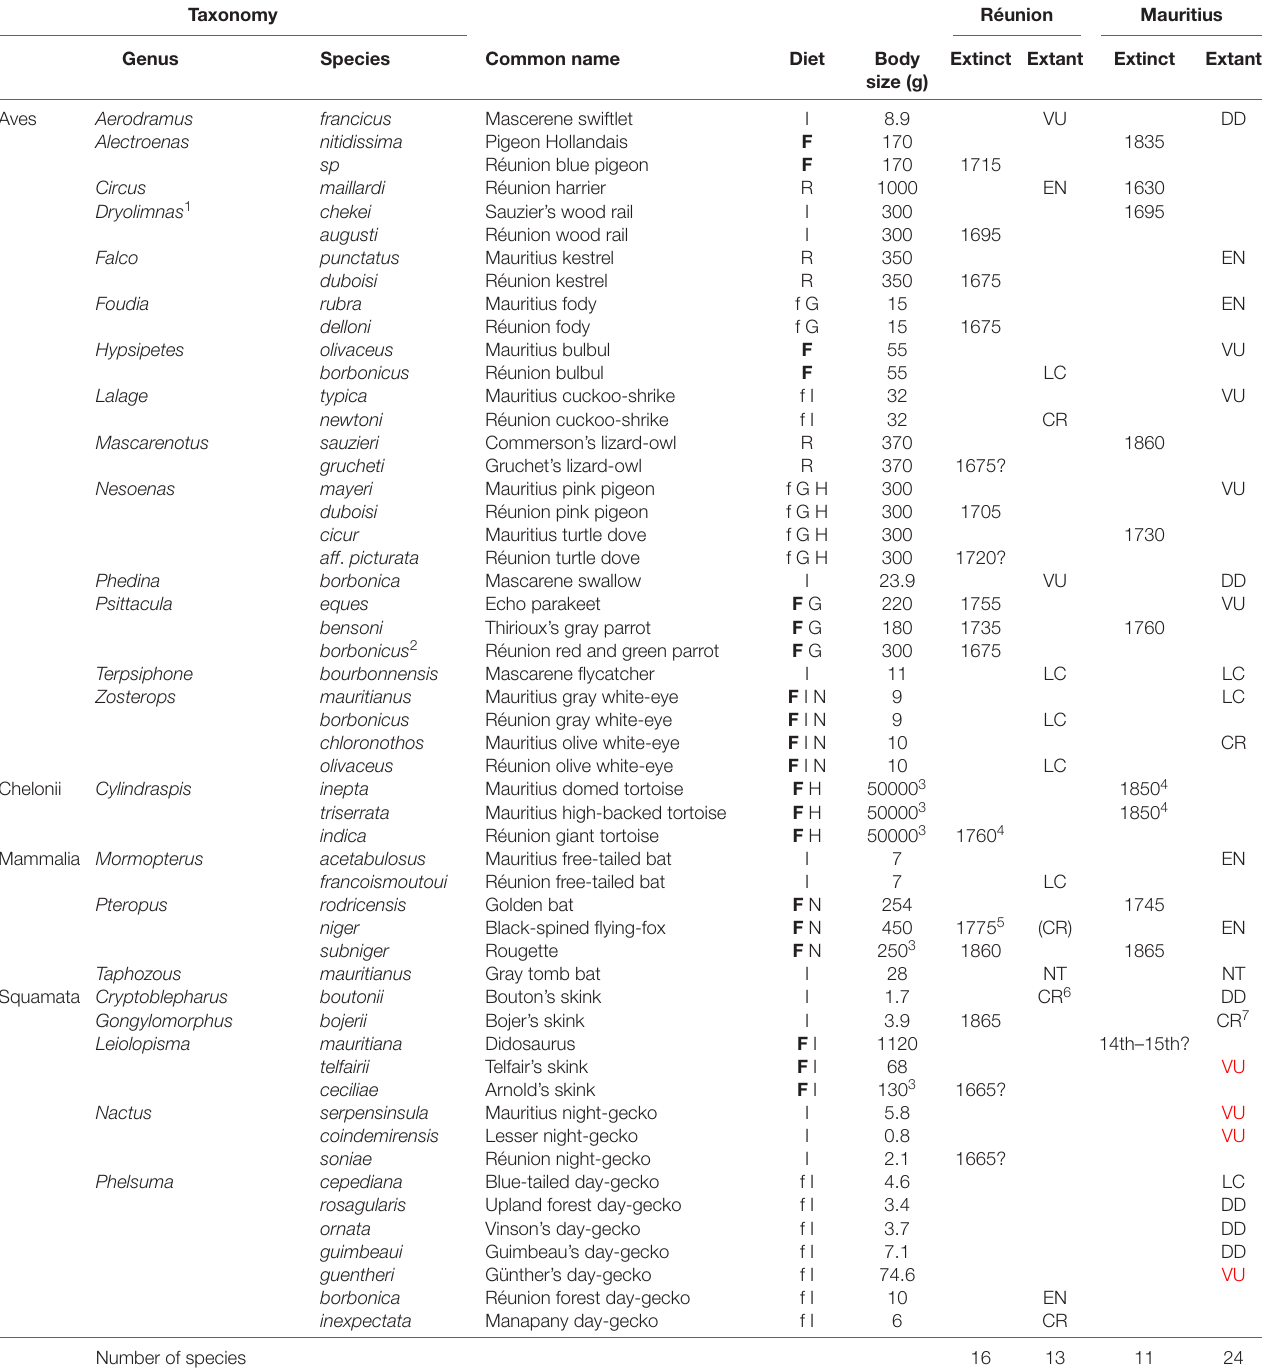
TABLE 1 | Overview of forest vertebrate lineages shared by Réunion and Mauritius in the pristine Mascarenes.